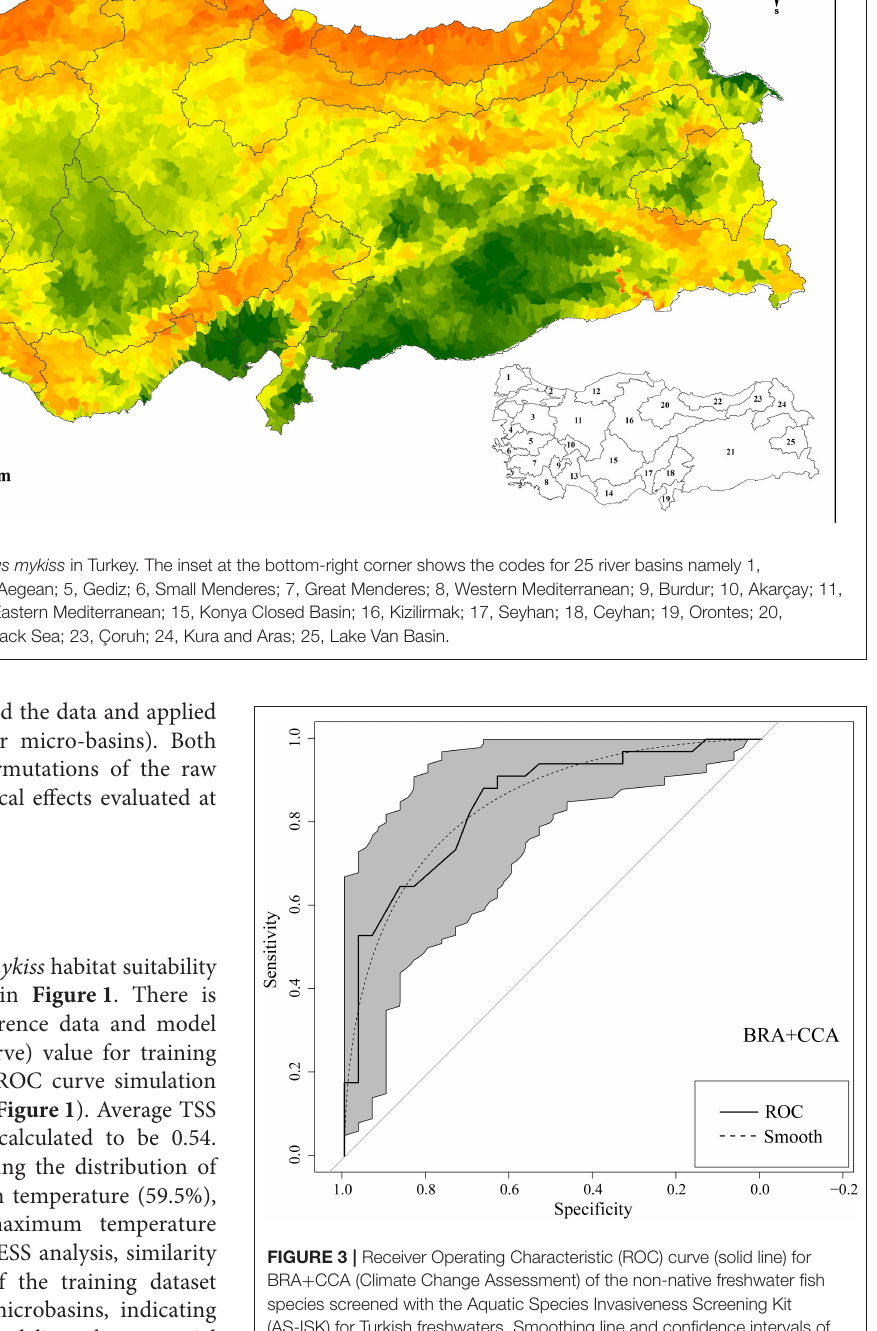
were predicted as the northern basins namely Eastern Black Sea, Western Black Sea and Marmara basins ( Figure 2